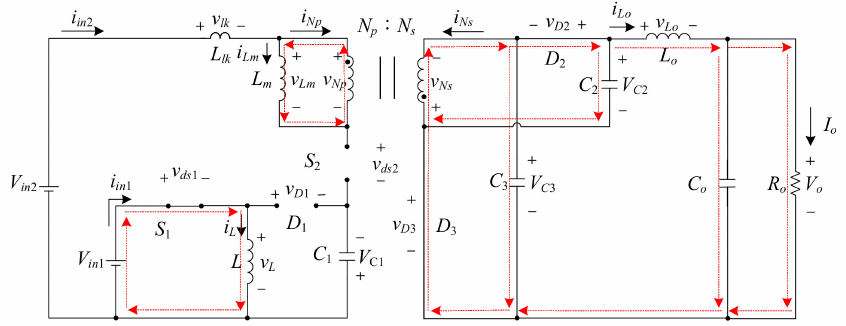
Figure 9. State 3 power flow.